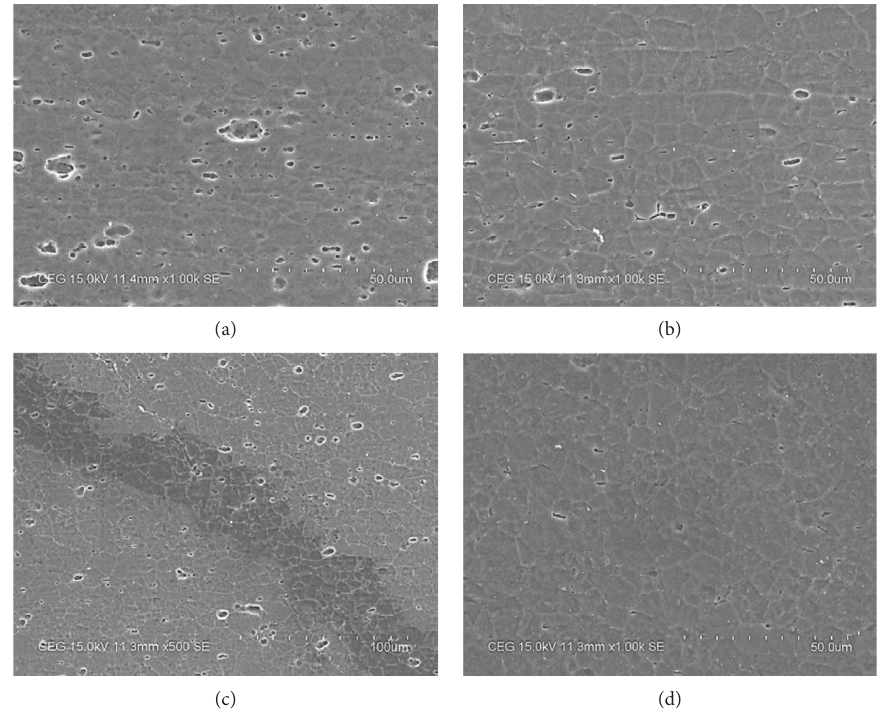
Figure 20: Detailed scanning electron microscopic image for cryogenic friction stir welding of AA 7075 aluminium alloy. (a) Parent. (b) HAZ. (c) Interface. (d) Weld nugget